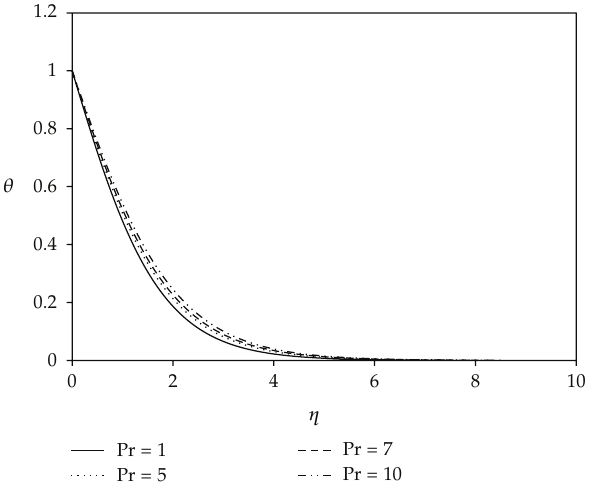
Figure 13: Temperature profile for di ff erent values of Pr for Du (cid:8) 0 . 03, Sr (cid:8) 2, θ r (cid:8) 5, Le (cid:8) 0 . 1, N (cid:8) 1, and Sc (cid:8) 0 .